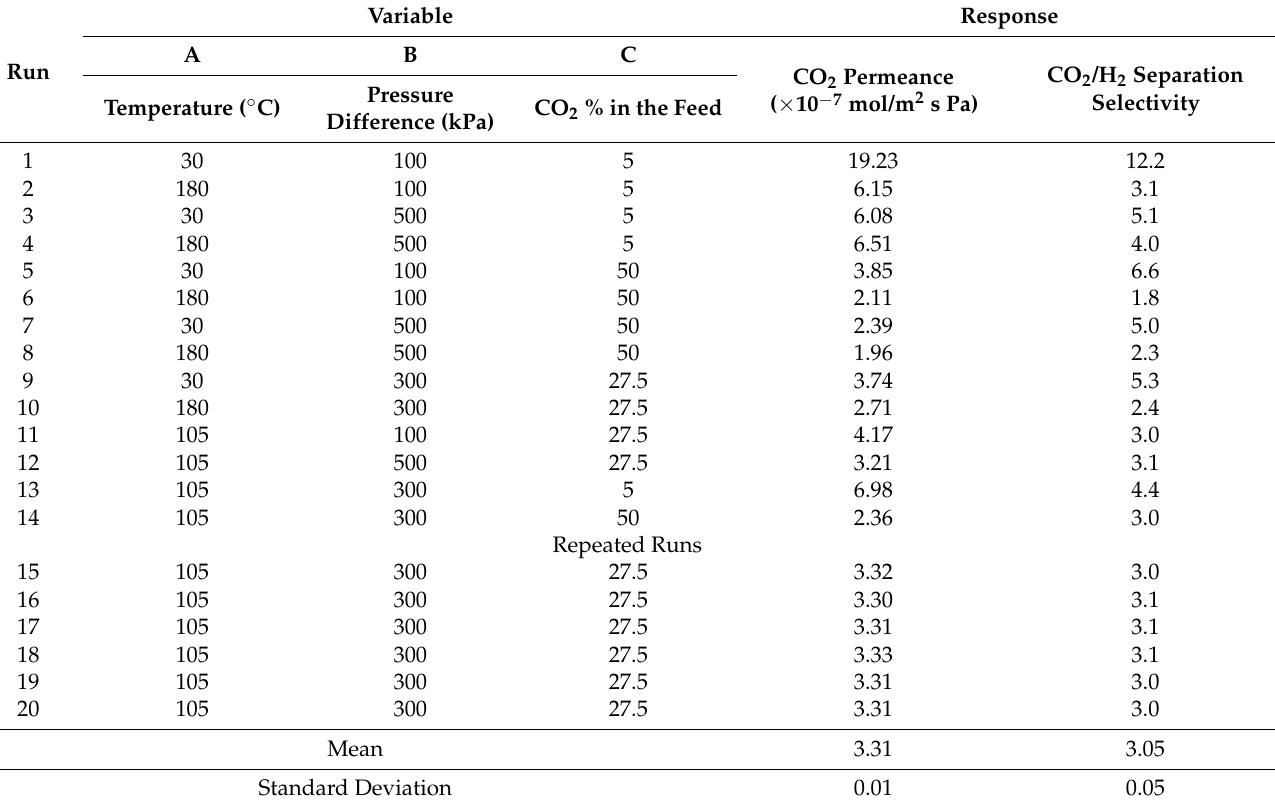
Table 2. Independent variables and responses for the CO 2 /H 2 separation studies.